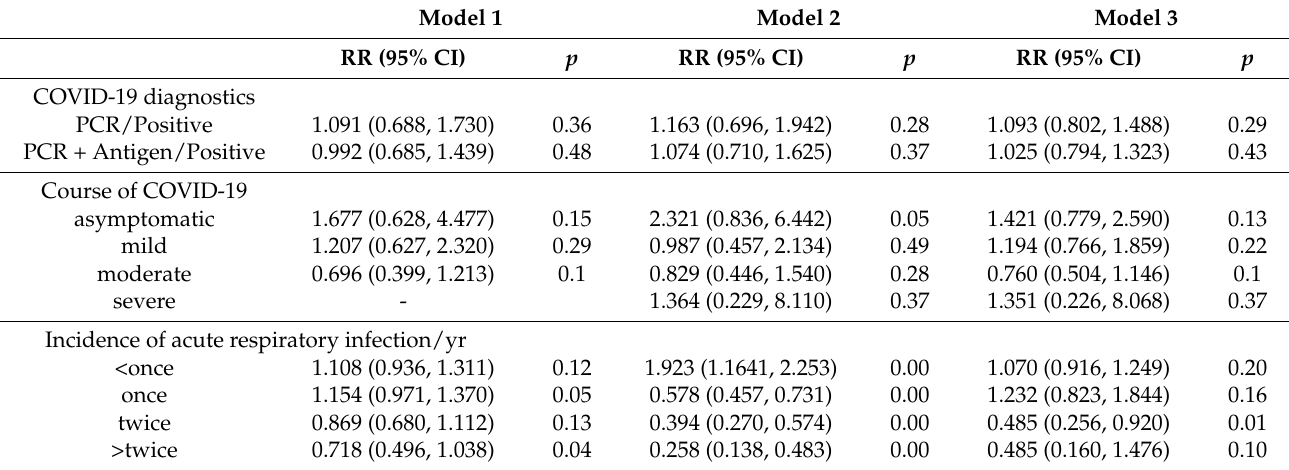
Table 3. Risk ratios for diagnostics and course of COVID-19 and acute respiratory infection ( n =